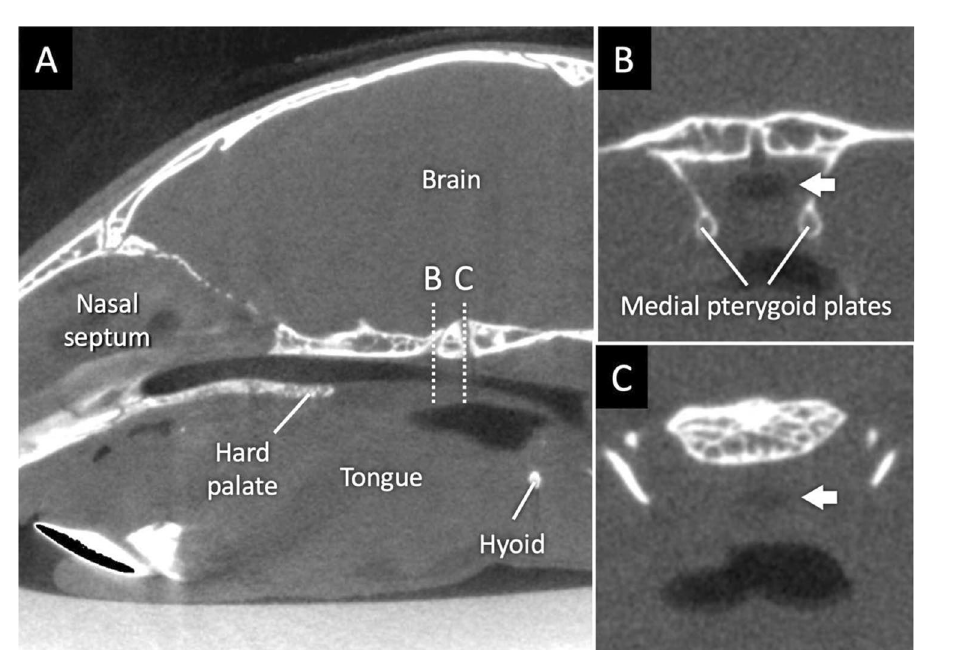
Figure 4. Upper airway collapse in a Dp16 mouse. ( A ) Upper airway collapse was observed in one of Dp16 mice. The mouse was breathing in the prone position during scanning. Dotted lines B and C are severely narrowed points which are surrounded by bones or soft tissues, respectively. Cross-sectional images, ( B ) and ( C ), were obtained from dotted lines B and C, respectively. White arrows indicate the collapsed